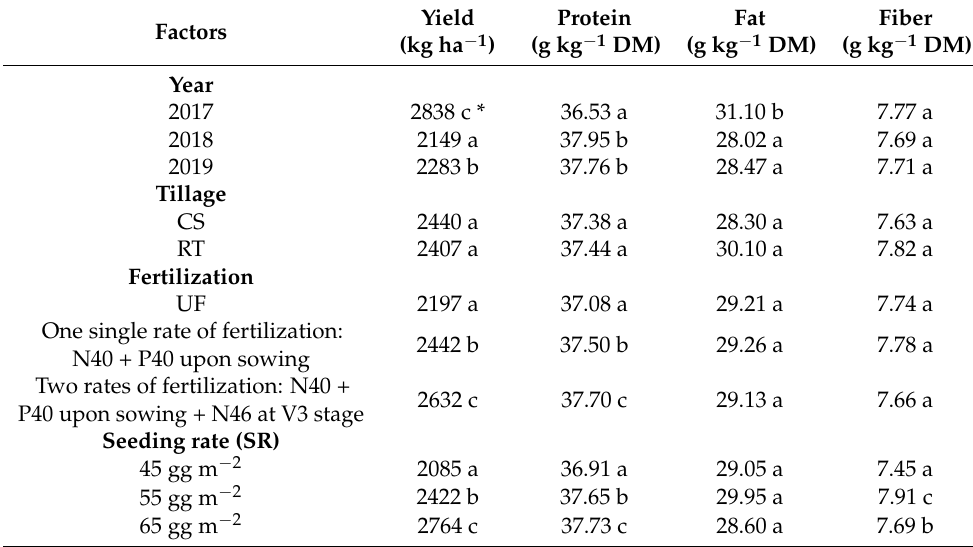
Table 4. Effect of the experimental factors on the soybean yield and qualitative